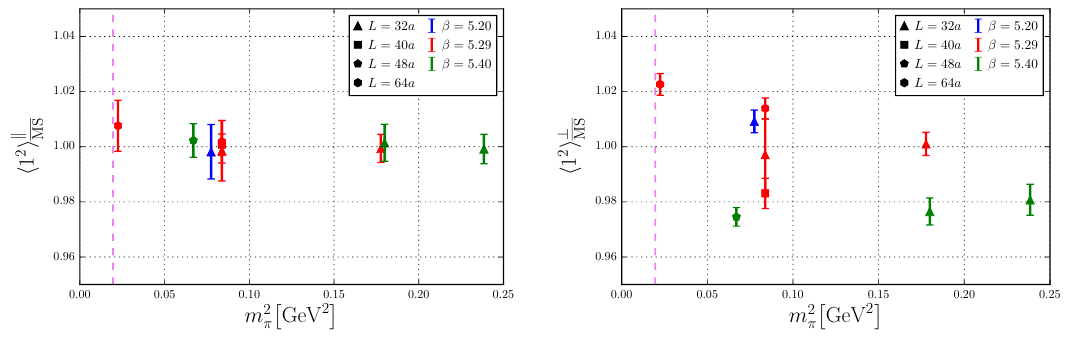
Figure 5 . The left and the right plot show indicates the position of the physical pion